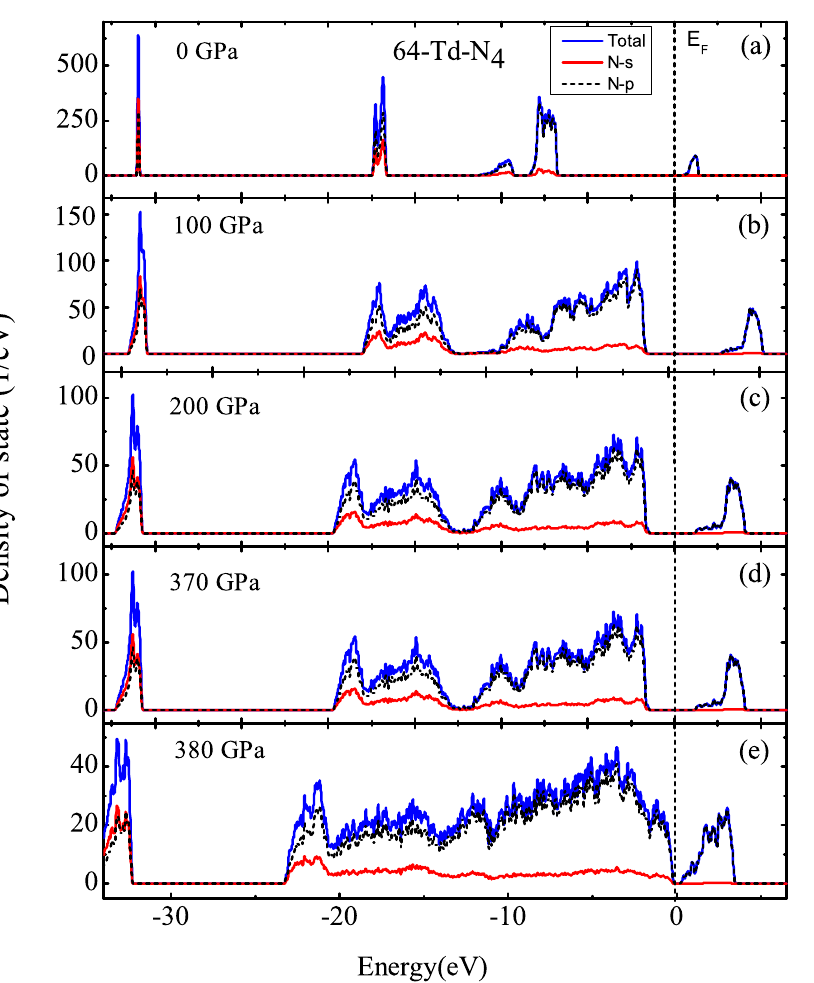
Figure 10. DOS of 64-Td-N 4 : ( a ) 0 GPa, ( b ) 100 GPa, ( c ) 200 GPa, ( d ) 370 GPa, ( e ) 380 GPa. Fermi level E F was set at